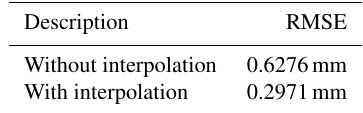
Figure 16. The tracking error. Table 3. Errors with and without the interpolation